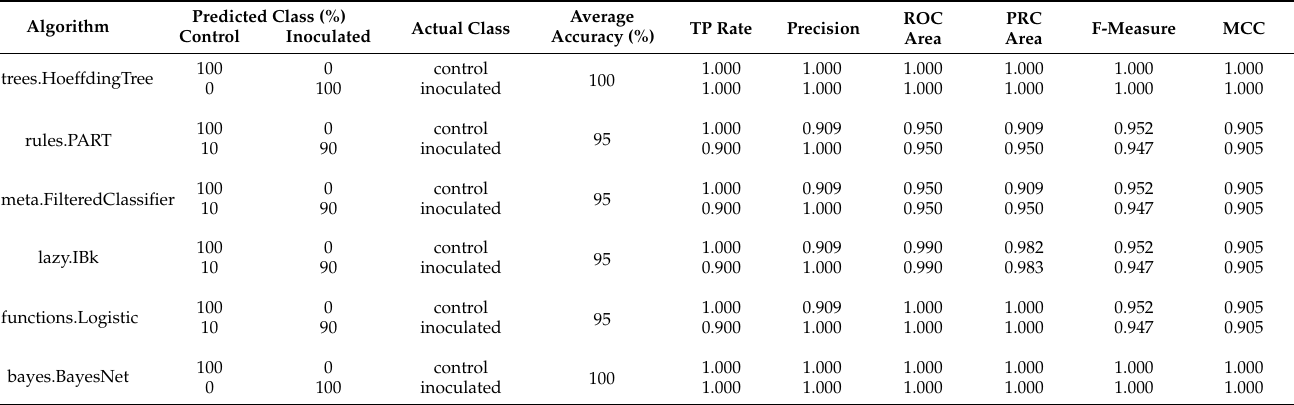
Table 1. The discrimination of the control and yeast-inoculated local dwarf tomato